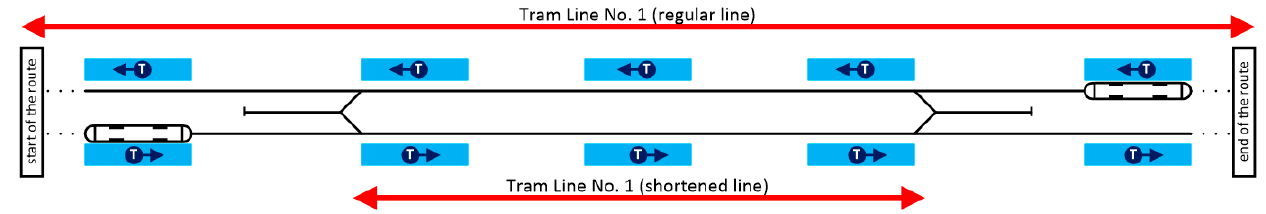
Figure 11. Using the bi-directional tram to diversify the routing of one tram line.